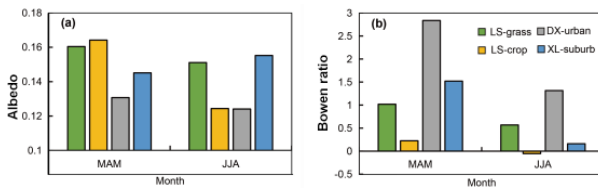
Figure 12. Seasonal averages of (a) albedo and (b) the Bowen ratio for the spring and summer at the four sites in Nanjing.